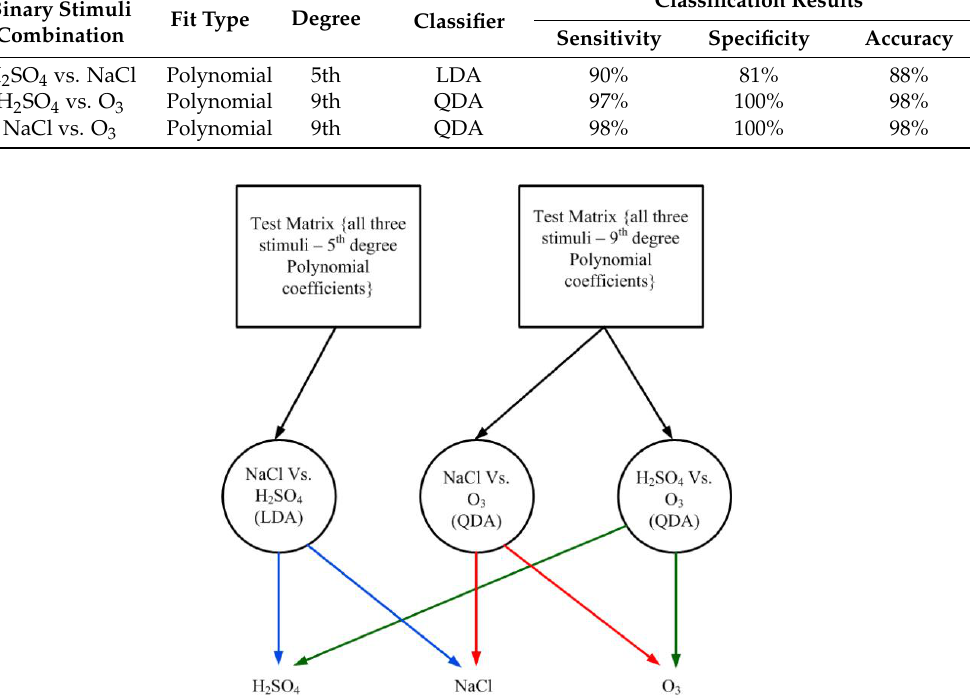
Figure 11. Prospective test method using One Versus One classification decision tree.